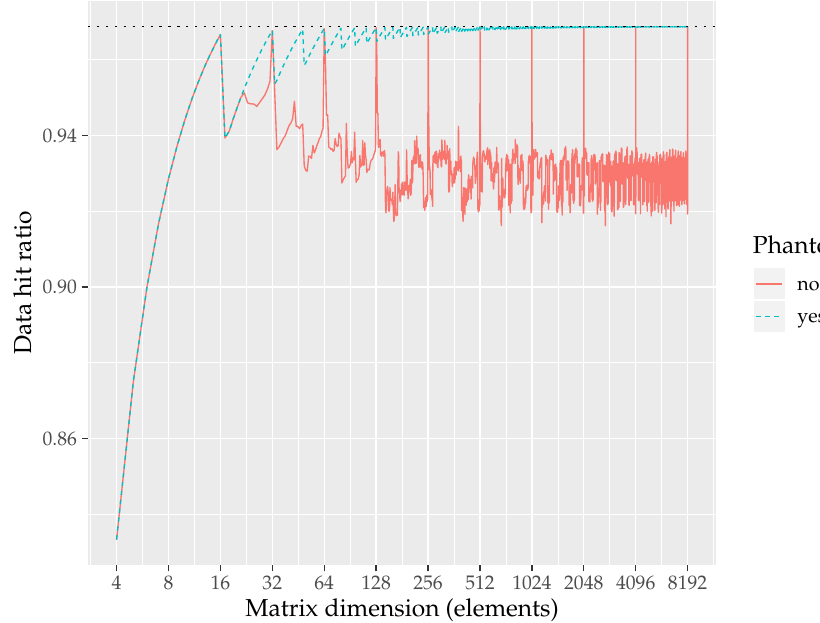
Figure 8. Data cache hit ratios without and with phantom padding (Algorithms 3 and 4) for the cache oblivious matrix transposition. The data cache is set to L = 16, S = 16 and W = 2. Matrix sizes vary from 4 4 to 8192 8192. The ideal data hit ratio (equations 2, 3, and 4) matches that of phantom padding. Black dotted line shows the upper bound hit ratio of eq. 1.